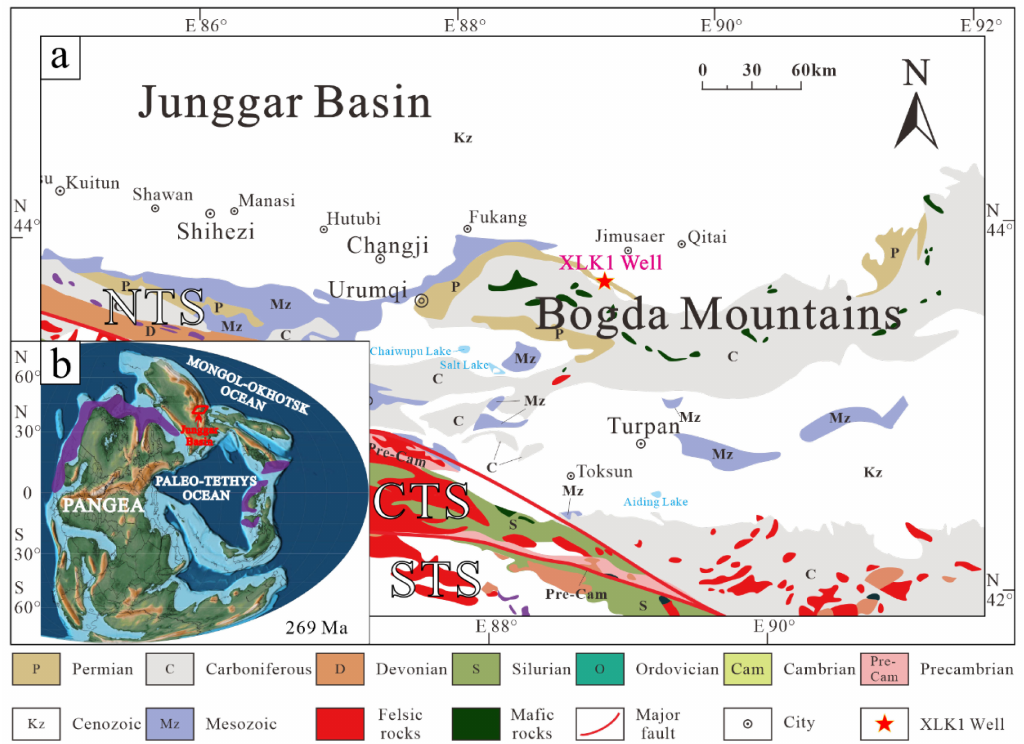
Figure 1. ( a ) Tectonic map of Bogda Mountain showing the location of XLK1 well (red star; adapted from Wang et al., 2018 [47]), NTS = North Tianshan, CTS = Central Tianshan, STS = South Tianshan; ( b ) Guadalupian–Lopingian global paleogeography (adapted from Scotese and Schettino, 2017 [48]), the location of Junggar Basin (circled by red line); the purple covered area shows the main distribution of Permian cherts reported to date